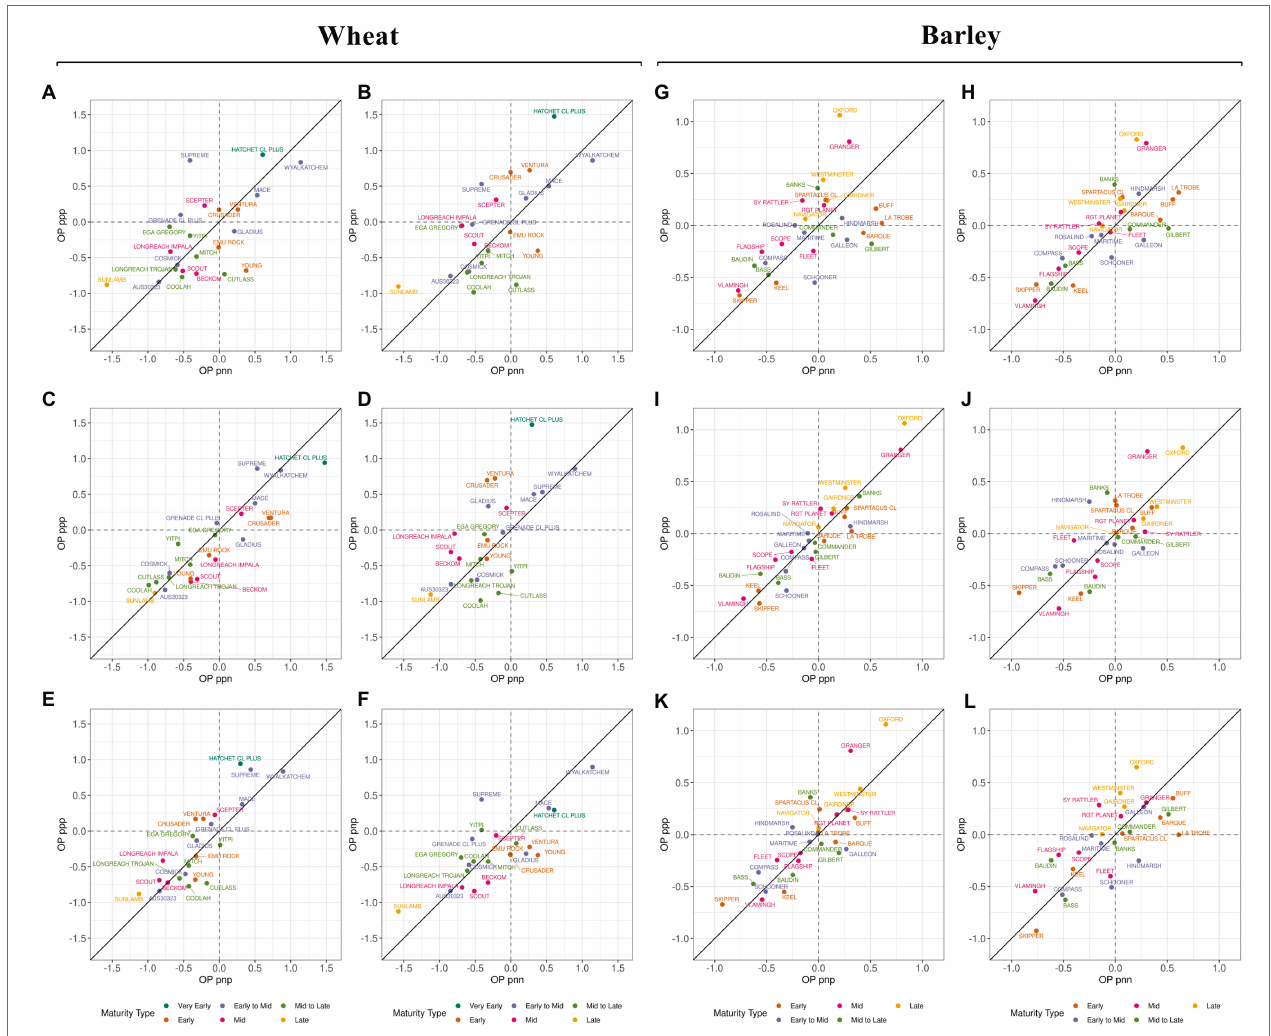
FIGURE 4 | Frost overall performance (OP) between I-classes in wheat (panels A-F) and barley (panels G-L). The I-classes are labeled with a three-character code (one for each factor), where each character is either “p” or “n” (for positive or negative loadings). Colors correspond to difference in maturity type. The FEEs within I-classes are presented in Table 6 and Supplementary Figure 1